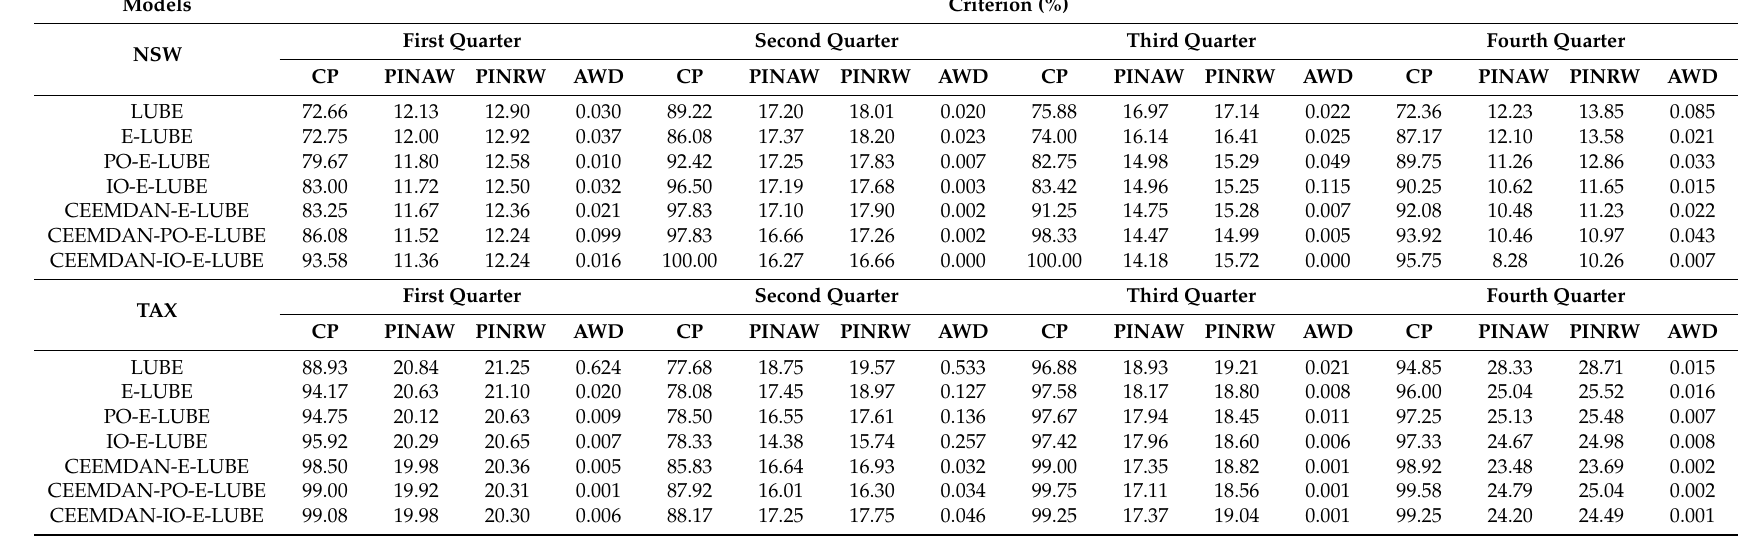
Table 2. Results of different models with α = 0.05 for sample in New South Wales (NSW) and Tasmania